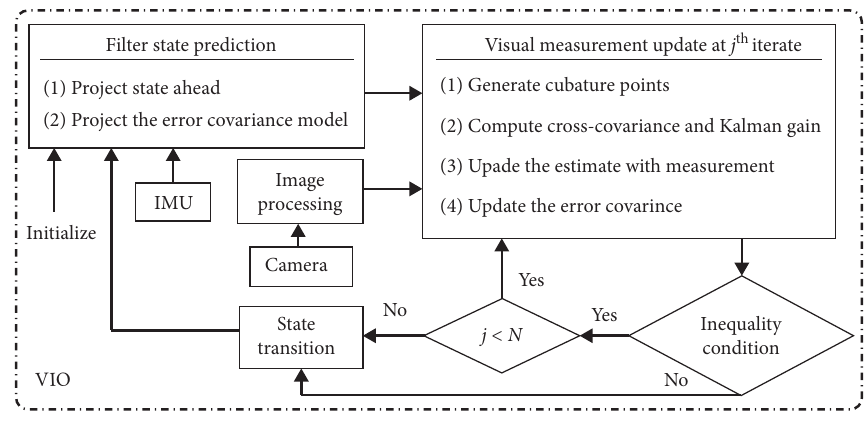
Figure 7: The system architecture implementing iterated CKF with j